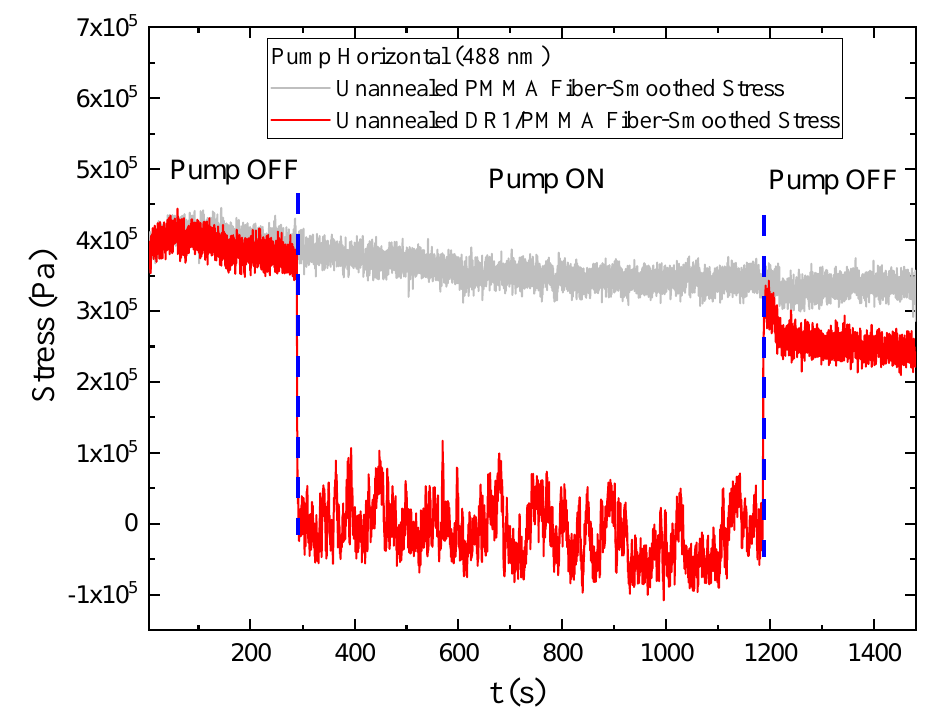
Figure 10. Stress as a function of time for unannealed PMMA and DR1/PMMA fibers when the pump is on and off.